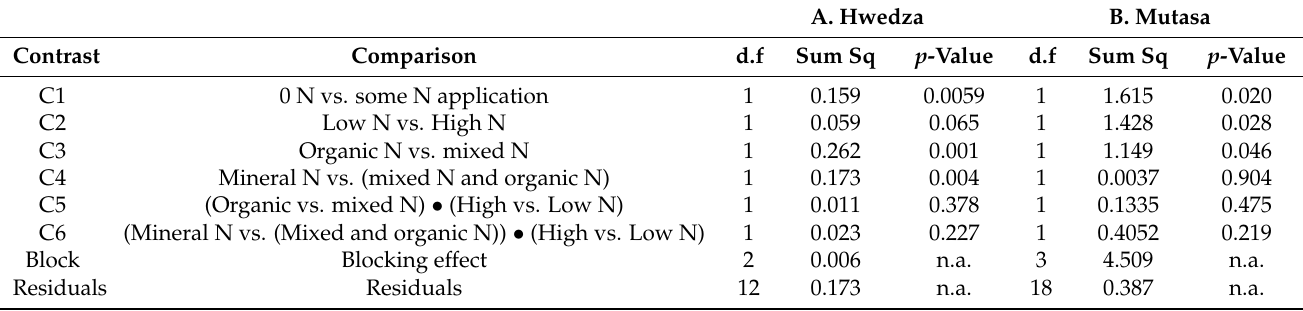
Table 7. ANOVA of contrasts showing effects of N management strategies on cowpea grain yields in Hwedza and Mutasa.